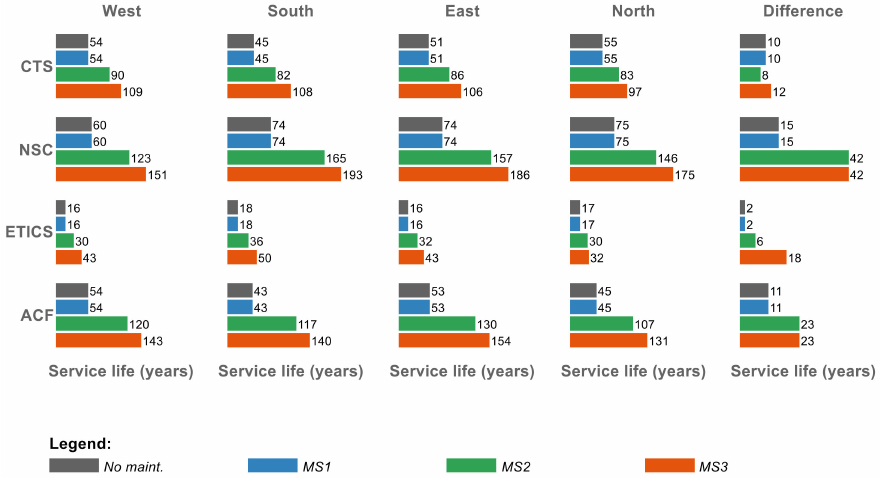
Figure 13. Comparison of the service life according to